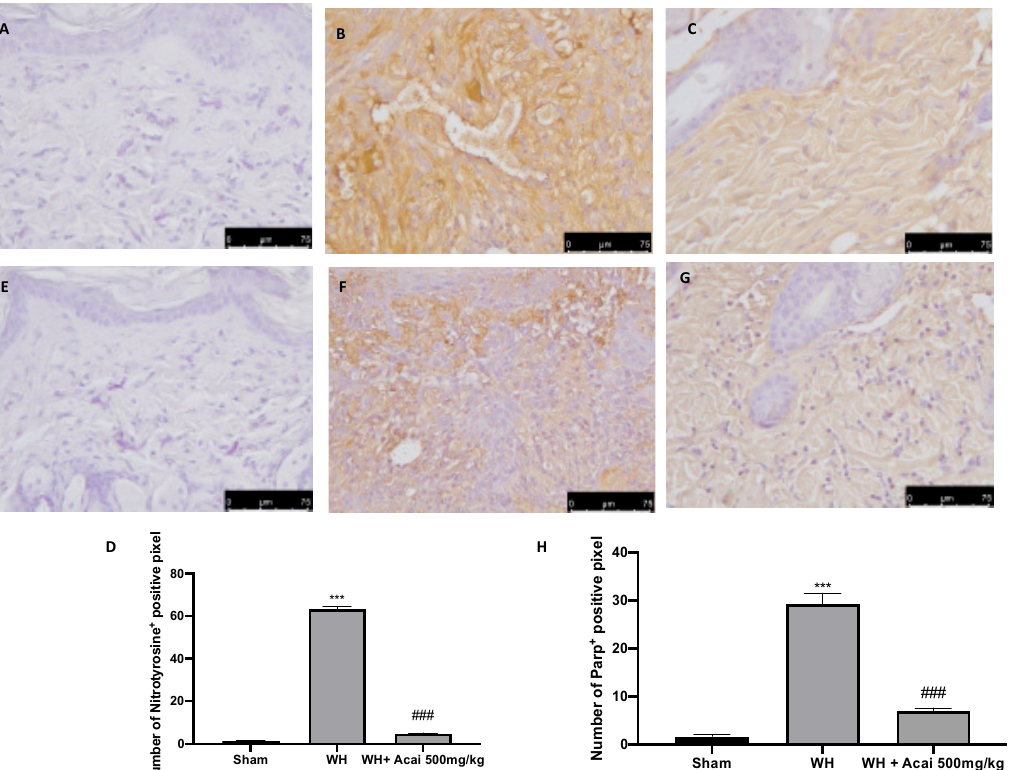
Figure 5. Immunohistochemical analysis was performed to evaluate the expressions of biomarkers of oxidative stress. nitrotyrosine expression: sham ( A ), WH ( B ), WH+ açai berry ( C ), % positive pixel for nitrotyrosine ( D ). Parp-1 expression: sham ( E ), WH ( F ), WH+ açai berry ( G ), % positive pixel for Parp-1 ( H ). A 75× magnification is shown. A demonstrative blot of lysates with a densitometric analysis for all animals is shown. Data are expressed as the mean ± SEM of N = 6 mice/group. *** p < 0.001 vs. sham; ### p < 0.001 vs. WH.